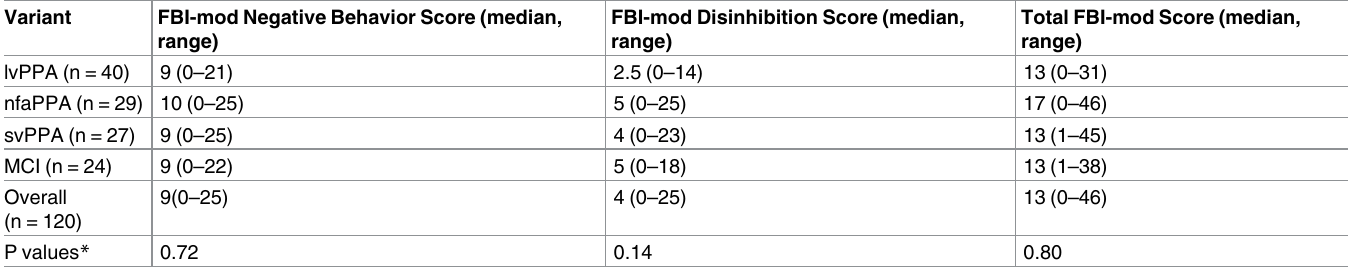
Table 2. Comparison of negative behavior, disinhibition, and total scores on the modified FBI between PPA subtypes and MCI. Variant FBI-mod Negative Behavior Score (median, range)